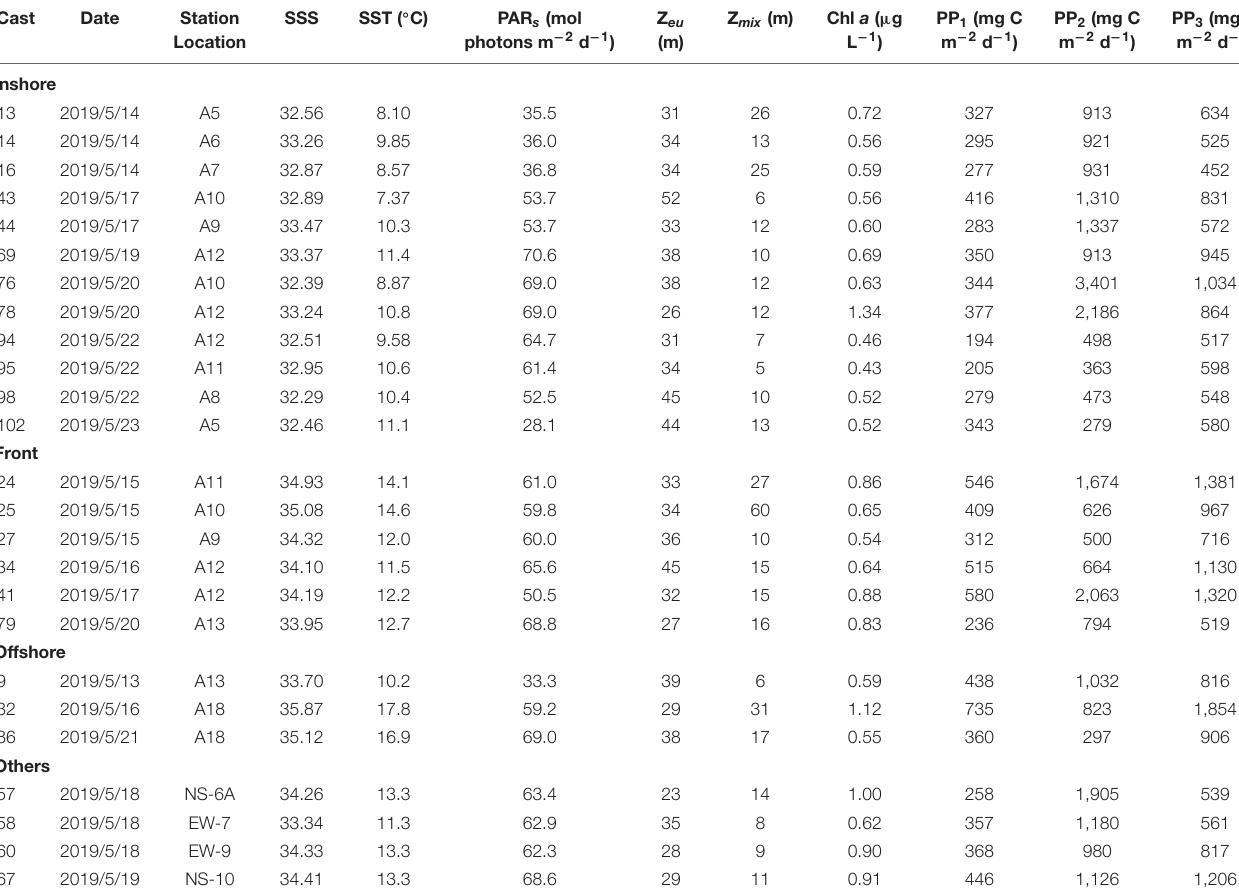
TABLE 3 | Primary productivity during